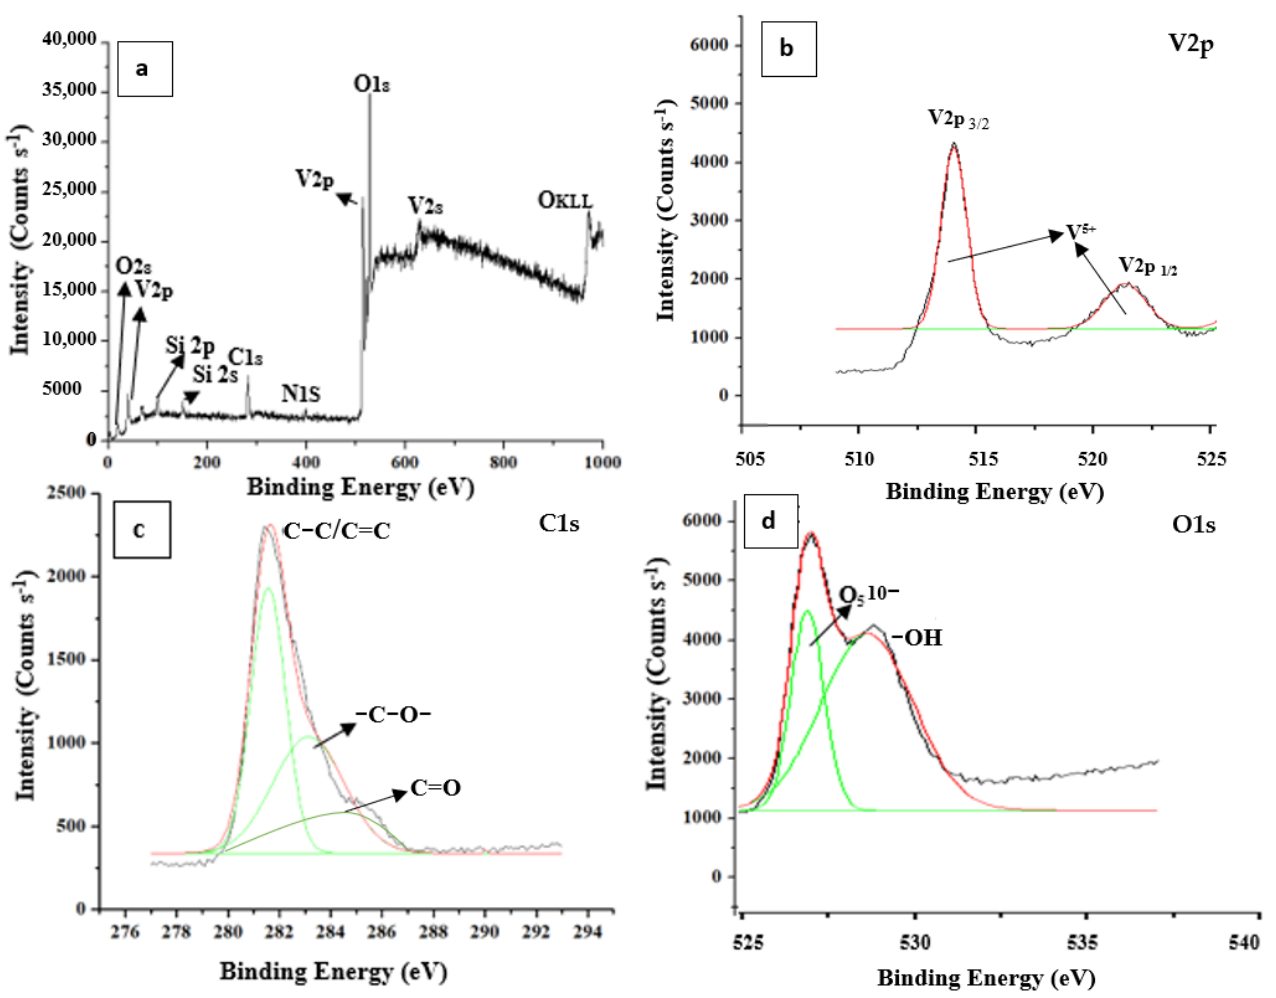
Figure 3. The interaction among SWCNT and V 2 O 5 nanoparticles was scrutinized by XPS data shown here. ( a ) Spectrum sample scanning with all elements of carbon, oxygen and vanadium. ( b ) V2p region with 2p3/2 and 2p1/2 orbit splitting showing V 5+ state. ( c ) C1s region deconvoluted to peaks, suggesting graphitic composition of SWNTs. ( d ) Asymmetrical O1s peak of XPS spectrum fitted with the predominant peak corresponding to O atoms in V 2 O 5 and the peak of hydroxyl groups in higher binding energy.